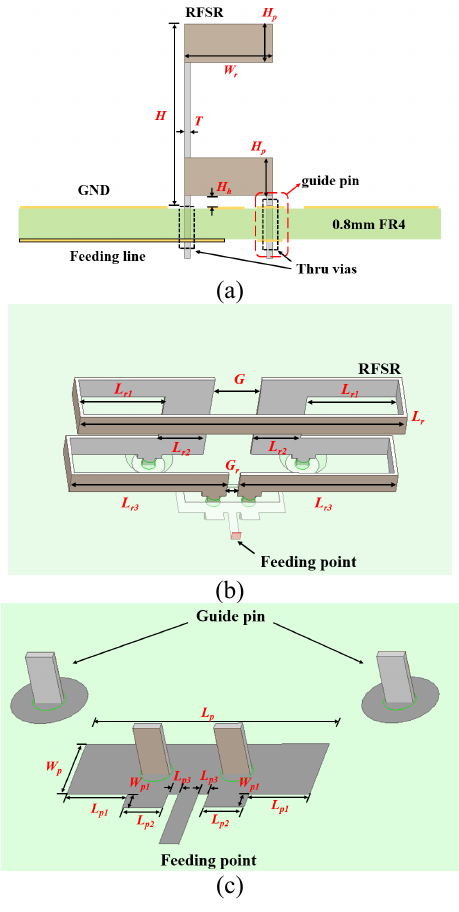
Figure 5: Geometry of the proposed miniaturized RFSR: (a) side view of the RFSR, (b) eagle view of the RFSR, and (c) geometry of the power divider structure. H = 9.5 mm, H p = 2 mm, H h = 0.5 mm, T = 0.3 mm, W r = 4.6 mm, G = 4 mm, G r = 1 mm, L r = 27.6 mm, L r1 = 7.5 mm, L r2 = 4 mm, L r3 = 11.8 mm, L p = 9 mm, L p1 = 2.25 mm, L p2 = 1.5 mm, L p3 = 0.38 mm, W p = 3 mm, and W p1 = 0.8 mm